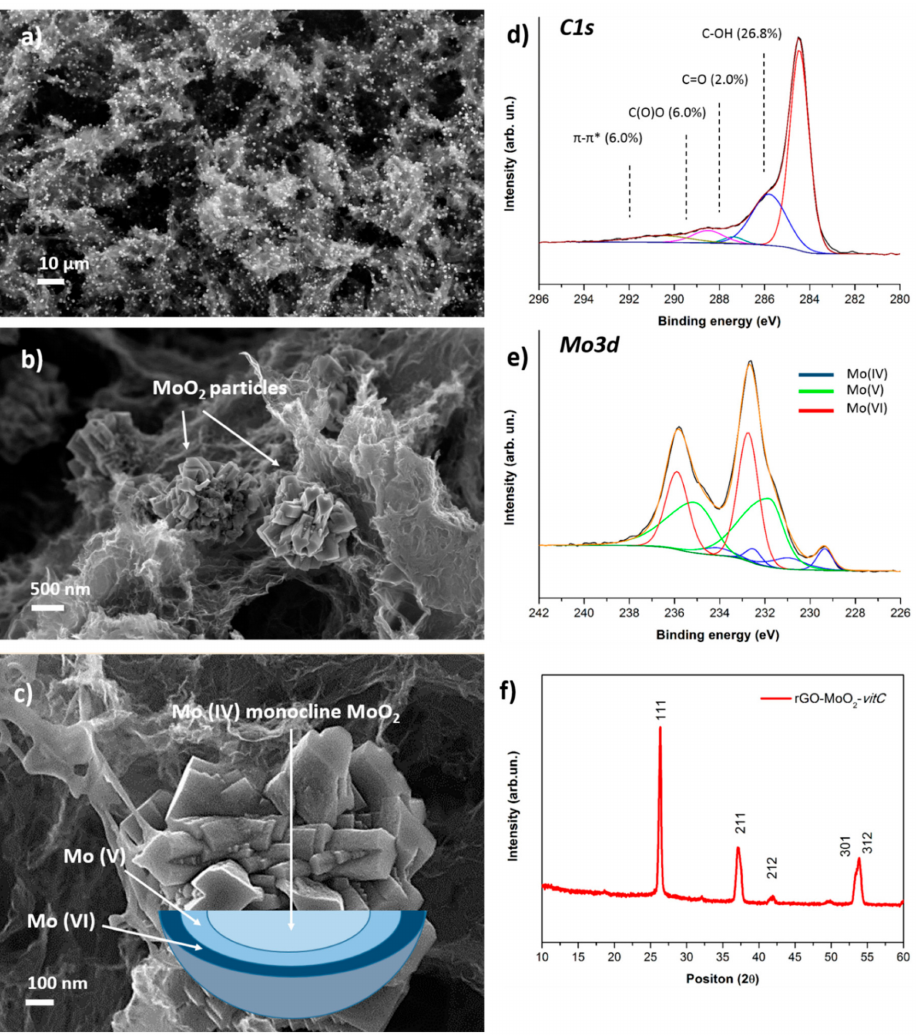
Figure 3. FESEM images at low ( a ) and high ( b ) magnification of the rGO-MoO 2 - vitC sample; ( c ) FESEM image of a MoO 2 particle with a schematic representation of the gradient of Mo oxidation state. XPS high-resolution scans of C1s ( d ) and Mo3d ( e ) regions for rGO-MoO 2 - vitC sample; ( f ) provides the XRD spectrum of the hybrid